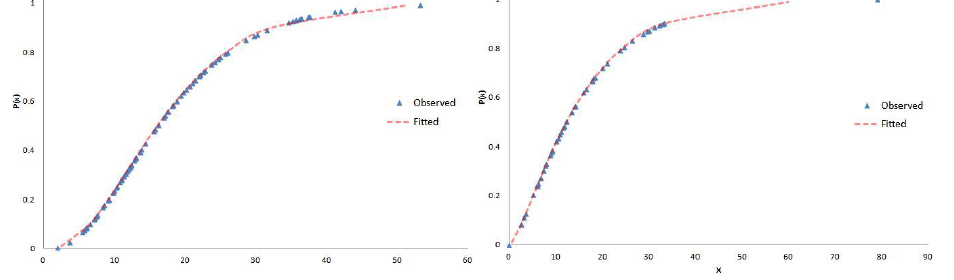
Fig. 6. Probability plots for the test catchments.